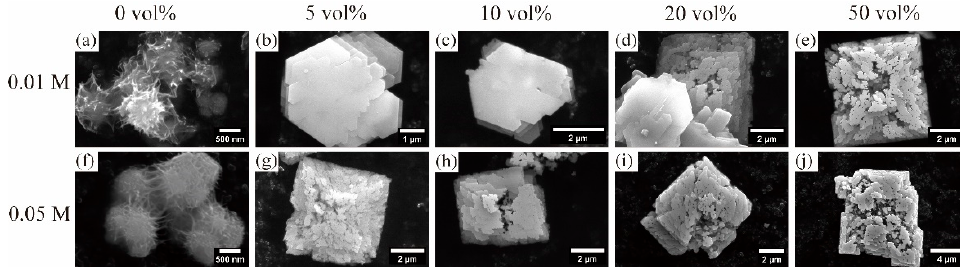
Figure 5. SEM images of samples 1–10 ( a – j ).